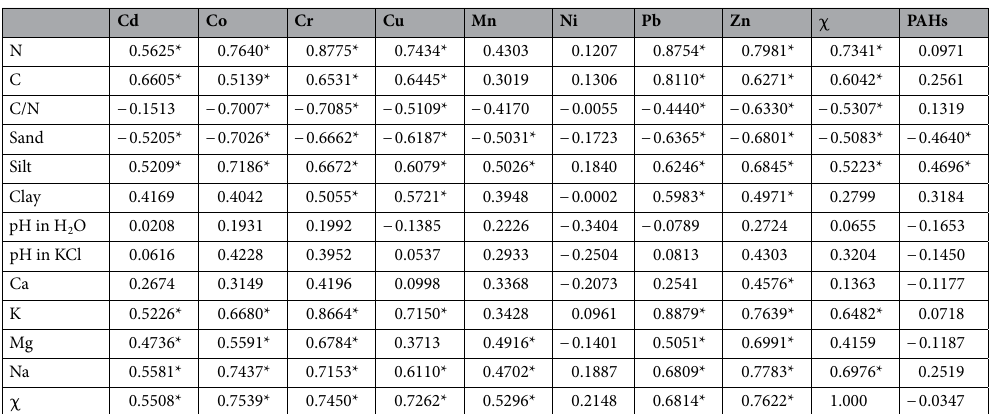
Table 5. Correlation between heavy metals content, PAHs content, magnetic susceptibility and soil properties. *p < 0.05.